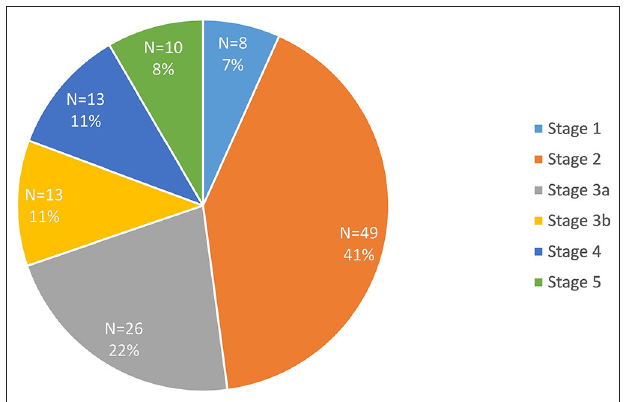
FIGURE 1 | Proportion of participants in each stage of chronic kidney disease (CKD).